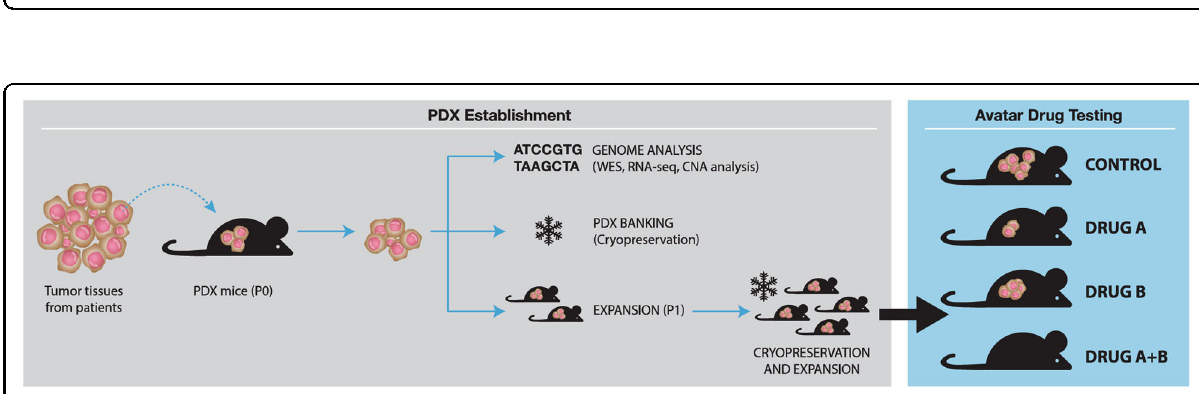
Fig. 1 Regulation of antitumor immunity and immunotherapy targets. a Programmed cell death protein-1 (PD-1) inhibits the activation and function of T cells. When PD-1 on activated T cells binds to programmed cell death ligand 1 (PD-L1) or programmed cell death ligand 2 (PD-L2) on tumor cells, T cells become inactivated, allowing tumor cells to evade the host immune response. Anti-PD-1 or PD-L1 antibodies can inhibit suppressive effects of tumor cells and enhance antitumor activities. b T-cell activation requires both TCR signaling and co-stimulatory signaling (CD28). When T cells get activated, cytotoxic T-lymphocyte-associated protein 4 (CTLA-4) is upregulated and displaced by CD28 binding to B7 due to higher binding af fi nity. The binding of B7 proteins to CTLA-4 inhibits T-cell activation